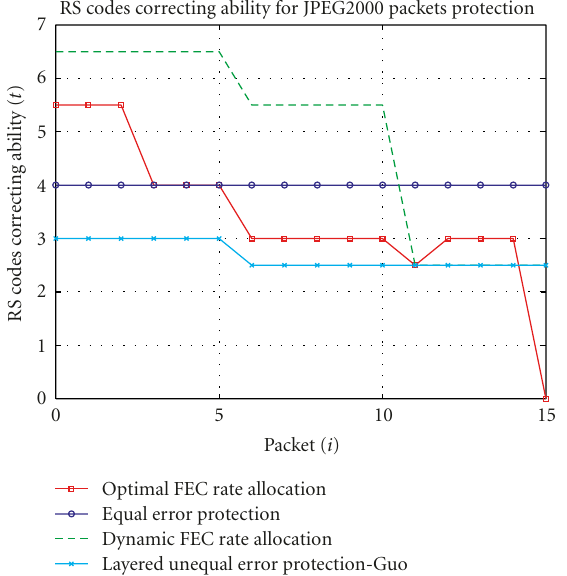
Figure 12: Correcting ability of the RS( n ,32) codes used for JPEG 2000 data packets—bandwidth of 6Mbps.